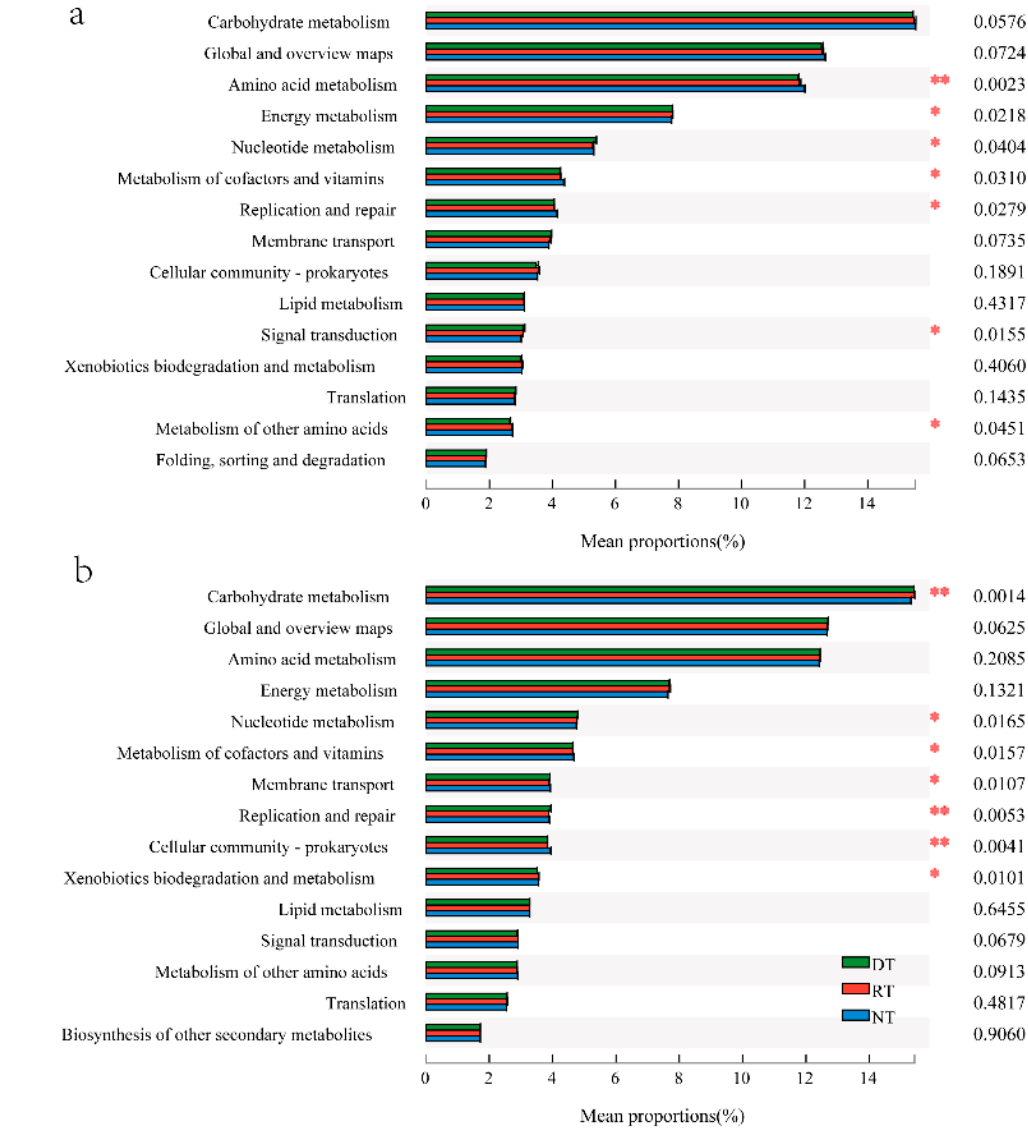
Figure 5. Analyses of the function-related differences focused on pathway level 2 using KEGG provided the top 15 represented pathways under different treatments in the wheat ( a ) and maize ( b ) seasons. *, ** indicate significant difference among treatments at p = 0.05, 0.01, respectively.